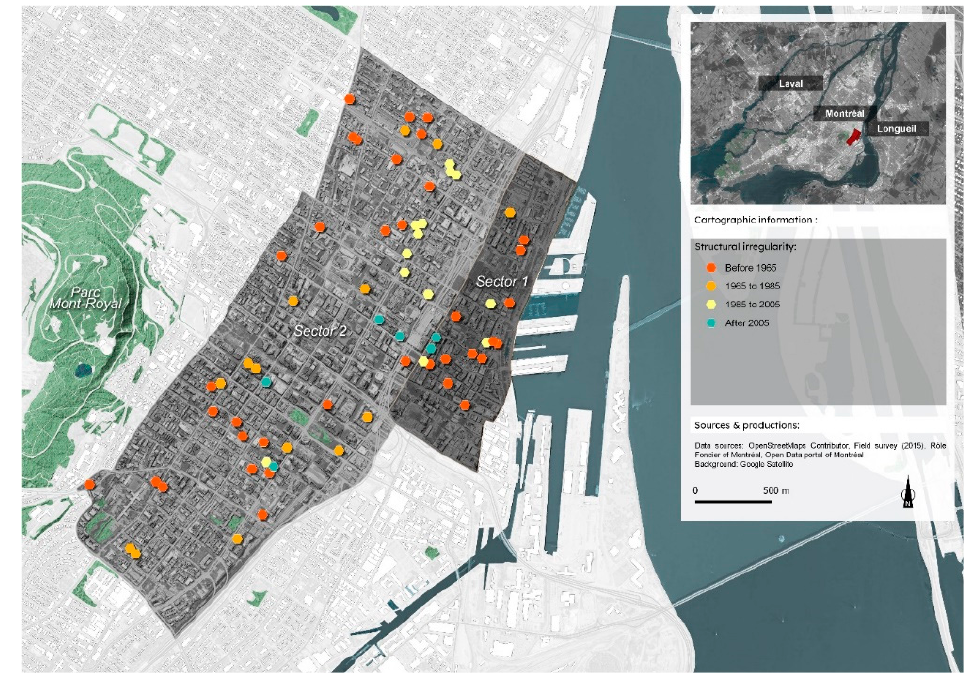
Figure 6. Distribution of the investigated buildings by period of construction: Hotels are divided into four groups of year of construction.